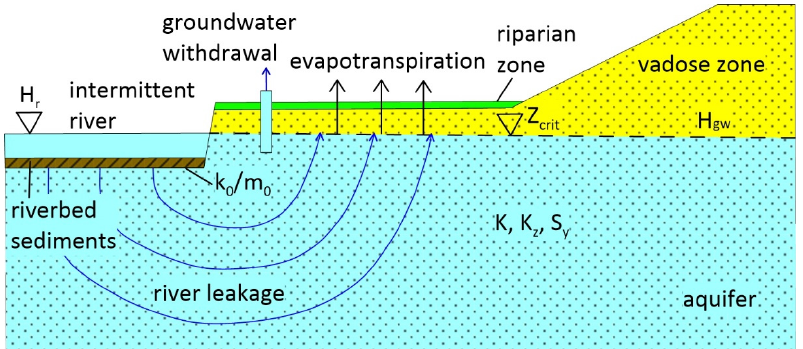
Figure 4. Conceptual diagram of the intermittent stream/terminal lake–aquifer–riparian zone evap- otranspiration–groundwater withdrawal system. Z crit —extinction depth of evapotranspiration; K and K z —horizontal hydraulic conductivity and vertical hydraulic conductivity, respectively, of the aquifer; S y —specific yield of the aquifer; k 0 /m 0 —ratio of riverbed hydraulic conductivity to riverbed thickness; H r and H gw —levels of surface water and groundwater, respectively.